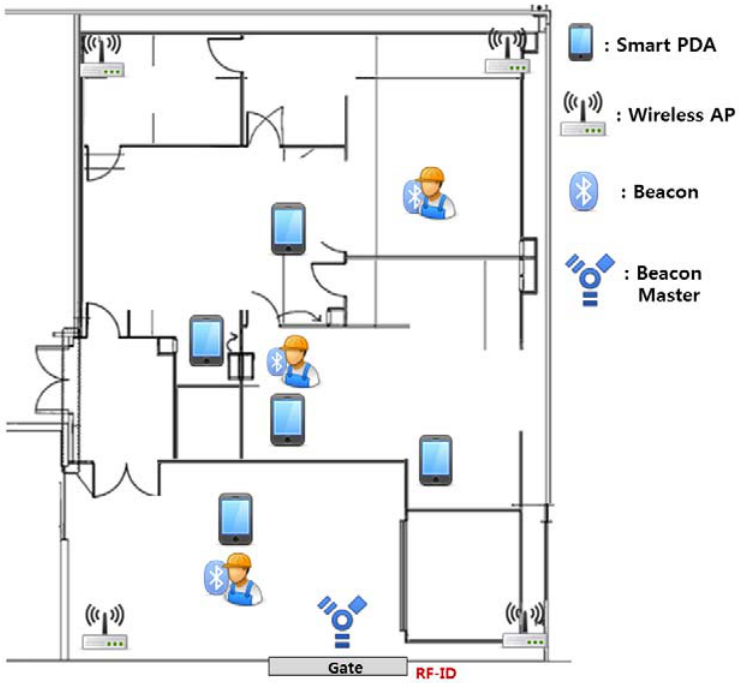
Figure 17. Bluetooth Beacon System Configuration and Location of Wi-Fi Devices Following Structure of Factory.